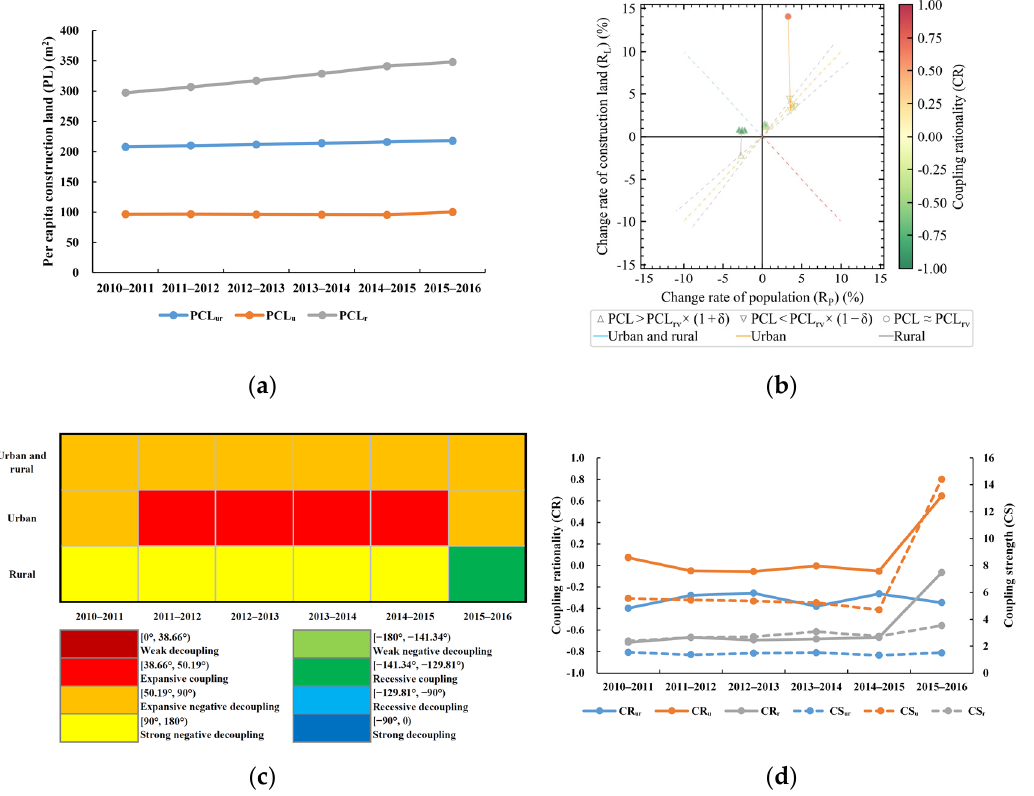
Figure 5. Static and dynamic coupling analysis of URCL and population in Henan province from 2010 to 2016: ( a ) PCL changes of URCL, UCL, and RCL; ( b ) coupling scatter plot; ( c ) changes of coupling angle and coupling types; ( d ) changes of coupling rationality and coupling strength. In the figure, CR ur , CR u , and CR r are the coupling rationality of URCL–URP, UCL–UP, and RCL–RP, respectively, and CS ur , CS u , and CS r are their coupling strengths.